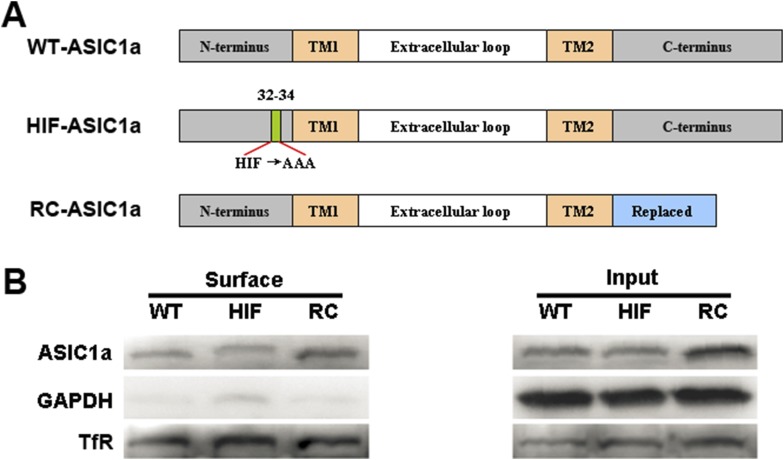
HIF and RC mutants of ASIC1a are normally expressed on the plasma membrane.(A) Diagrams of the wild-type (WT) and mutant ASIC1a constructs. (B) Membrane expression of WT-ASIC1a and its HIF and RC mutants as determined by surface biotinylation experiments.